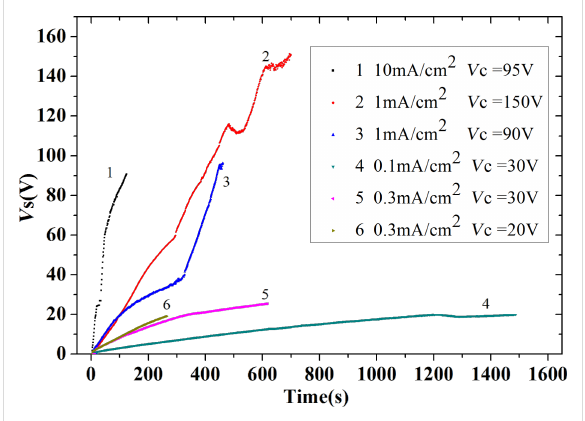
Figure 7: Film voltages as a function of the time obtained varying the current density and compliance voltages for different samples in our NbN anodization process. The number close to each curve is associat- ed with the current and voltage parameters indicated in the